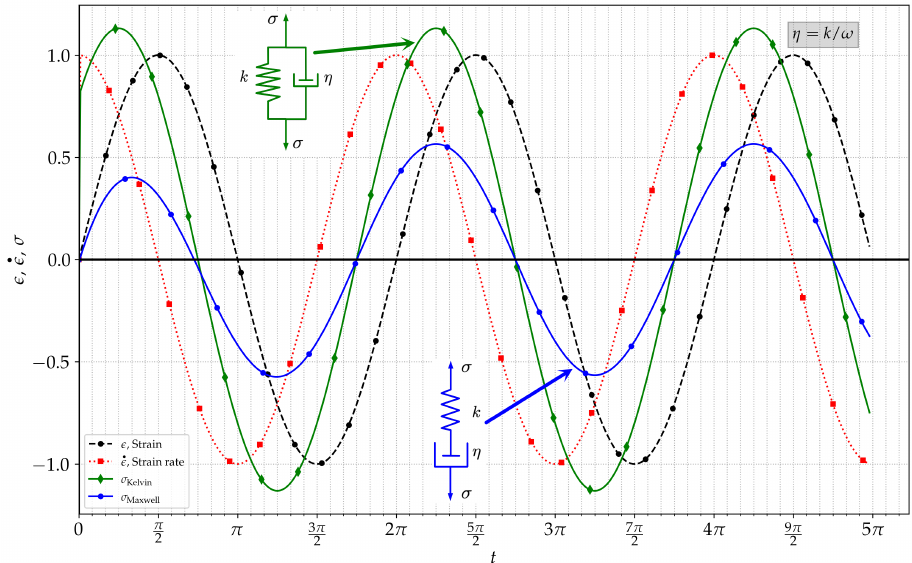
Figure 3. Strain, strain rate, and stress evolution in time for ideal Maxwell and Kelvin models forced with a synthetic strain (cid:101) = (cid:101) 0 sin ( ω t ) . Curves for (cid:101) = 1.0, ω = 1.0, k = 0.8, η = k / ω